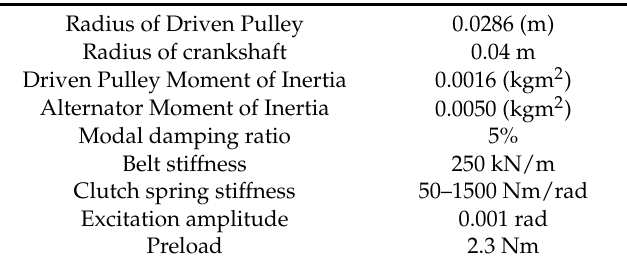
Table 1. Parameters for typical cases.